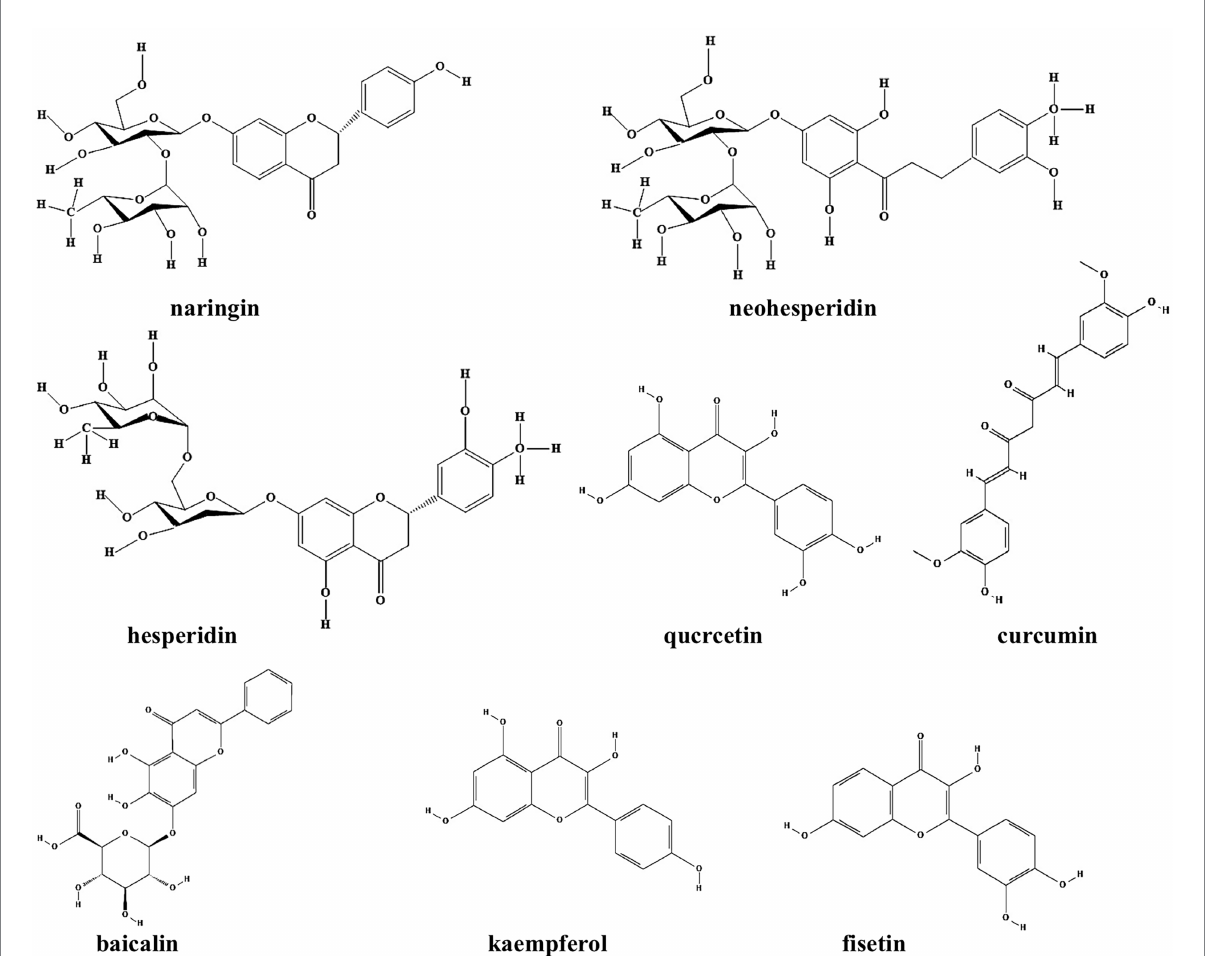
FIGURE 2 Chemical structures of the different flavonoids that inhibit biofilm formation via QS. ChemDraw software has been utilized to draw the chemical structures of the